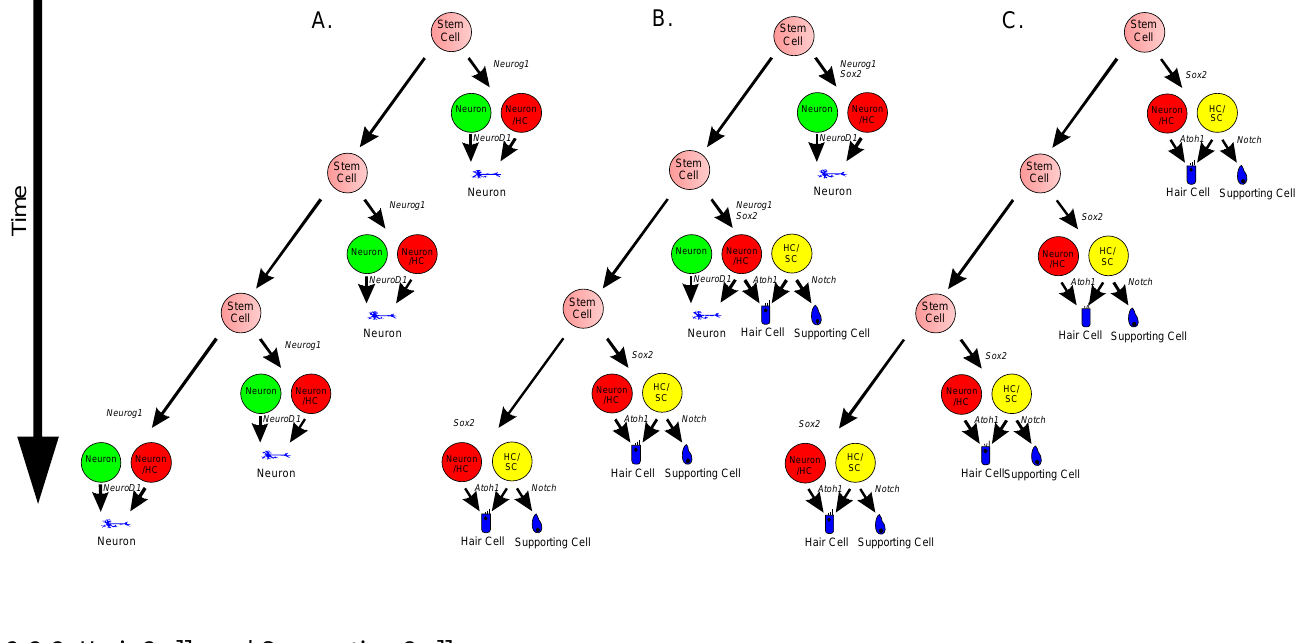
Figure 4. Fate restriction of either an EPI-NCSC or iPSC (pink) yields an additional stem cell (through asymmetric division) and a stem cell/precursor cell which can form a neuron, hair cell, or supporting cell. Clonal and temporal definitions of stem cells in the ear yield unique subsets of differentiated cells. A neuronal precursor (green) will give rise to neurons in the presence of Neurog1 and NeuroD1 (A). Neurosensory precursor stem cell populations that will give rise to either neurons and hair cells (red) or hair cells and supporting cells (yellow) are Neurog1 and Sox2 positive [60]. In the presence of NeuroD1 , a neuron is formed. In the absence of NeuroD1 but in the presence of Atoh1 , a hair cell is formed. Lastly, in the absence of both NeuroD1 and Atoh1 , DELTA/NOTCH signaling stabilizes the supporting cell fate [60]. It is possible that over time, there is a temporal restriction of a stem cell to allow for first a neuronal fate and later hair cell and supporting cell fate (B). Furthermore, a Sox2 positive cell may only give rise to hair cells and supporting cells but never neurons